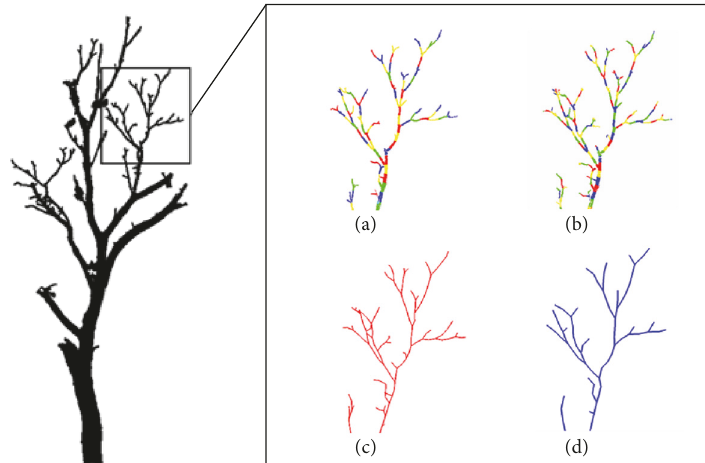
Figure 9: Comparison shortest path method and the proposed method. (a) The clusters of point cloud by using shortest path method. (b) The clusters of point cloud by using the proposed method. (c) The tree skeleton extracted by the shortest path method. (d) The tree skeleton extracted by the proposed